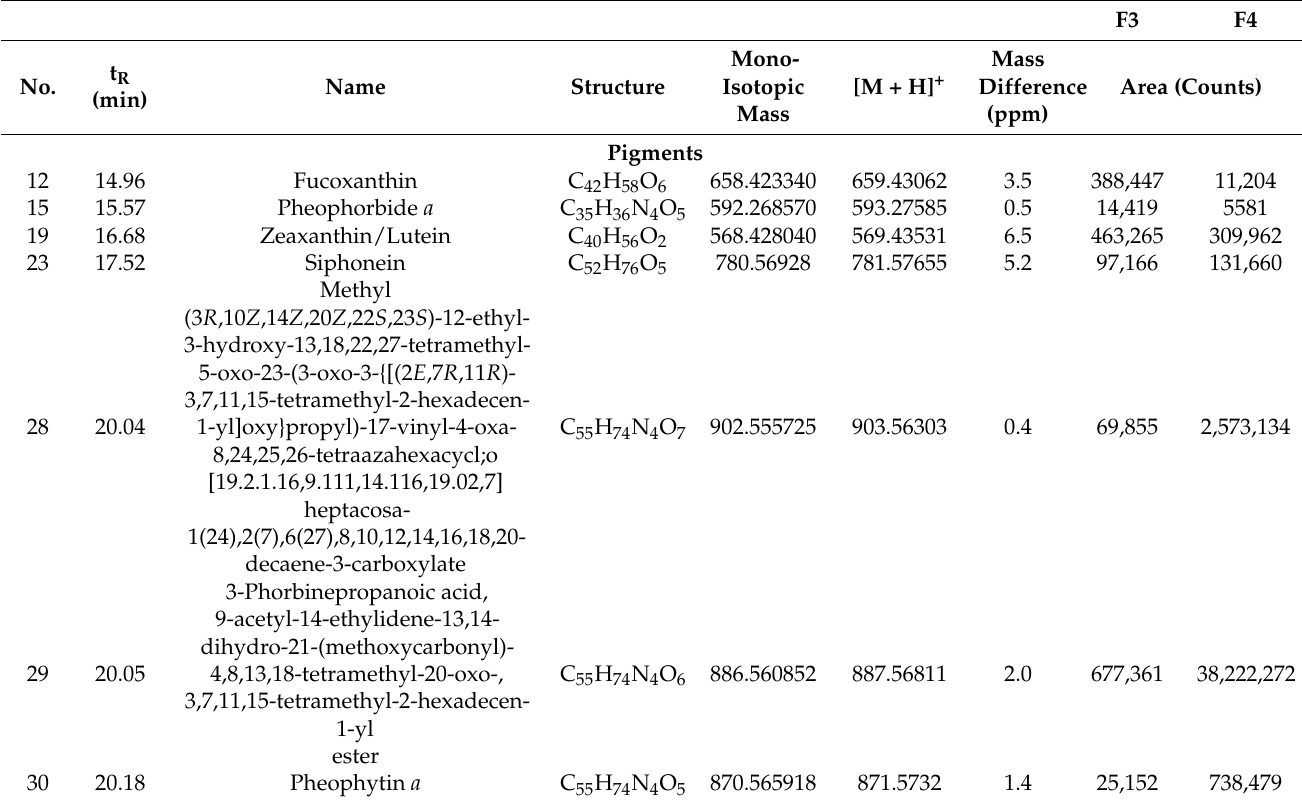
Table 3. Major nonvolatile compounds in F3 and F4 fractions and their plausible identification by UHPLC-ESI(+)–HRMS.